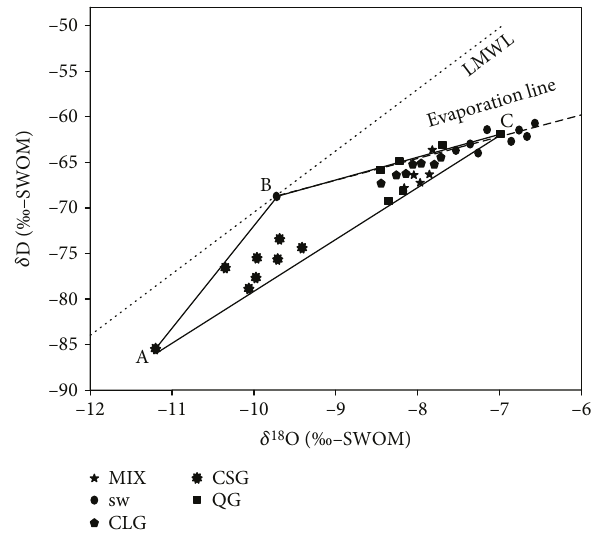
Figure 7: δ D – δ 18 O plot showing the mixing process of groundwater. MIX: mixing water; CLG: Cambrian aquifer groundwater; QG: Quaternary aquifer groundwater; sw: surface water; CSG: coal-bearing sandstone aquifer groundwater.